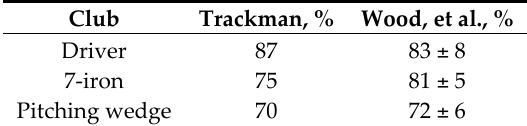
Table 1. Comparison of launch ratios in the vertical